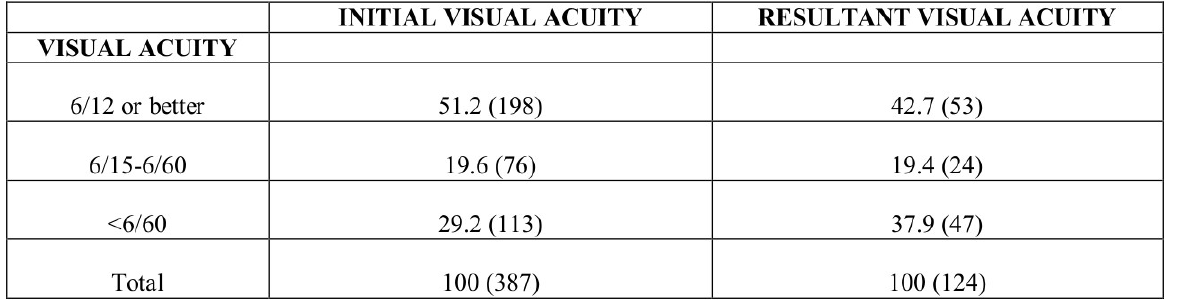
Table 3. Shows initial and final Snellen visual acuity (columns: % ( n